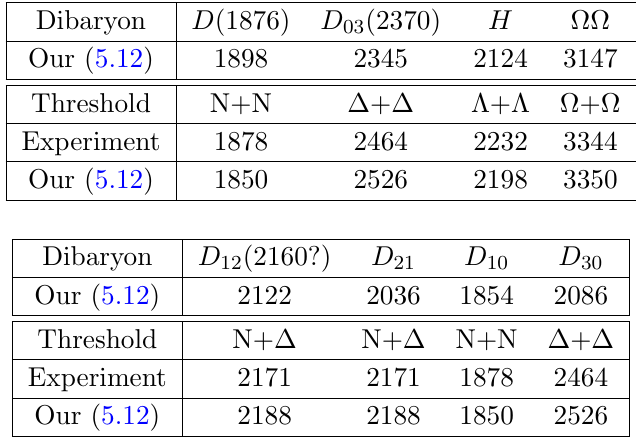
Table 7 . Comparison to the threshold for our formula (5.12) with (5.18) and